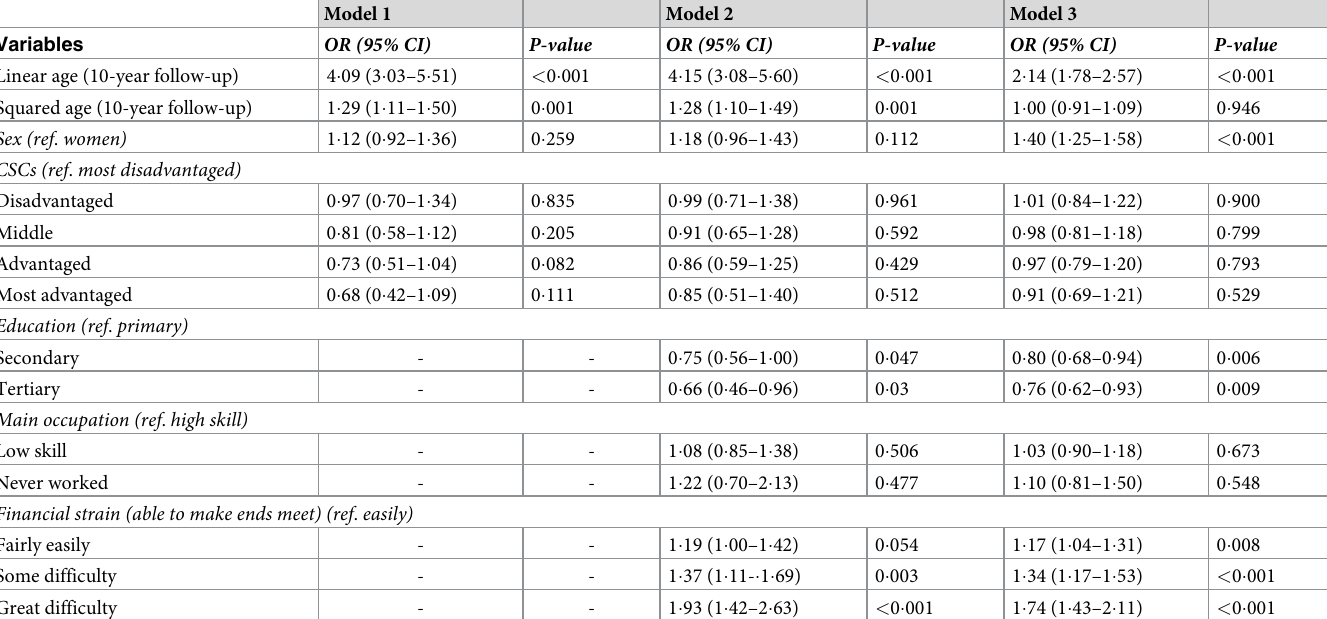
Table 4. Association of childhood socioeconomic conditions (CSCs) with odds of polypharmacy at age 73 years. (N =